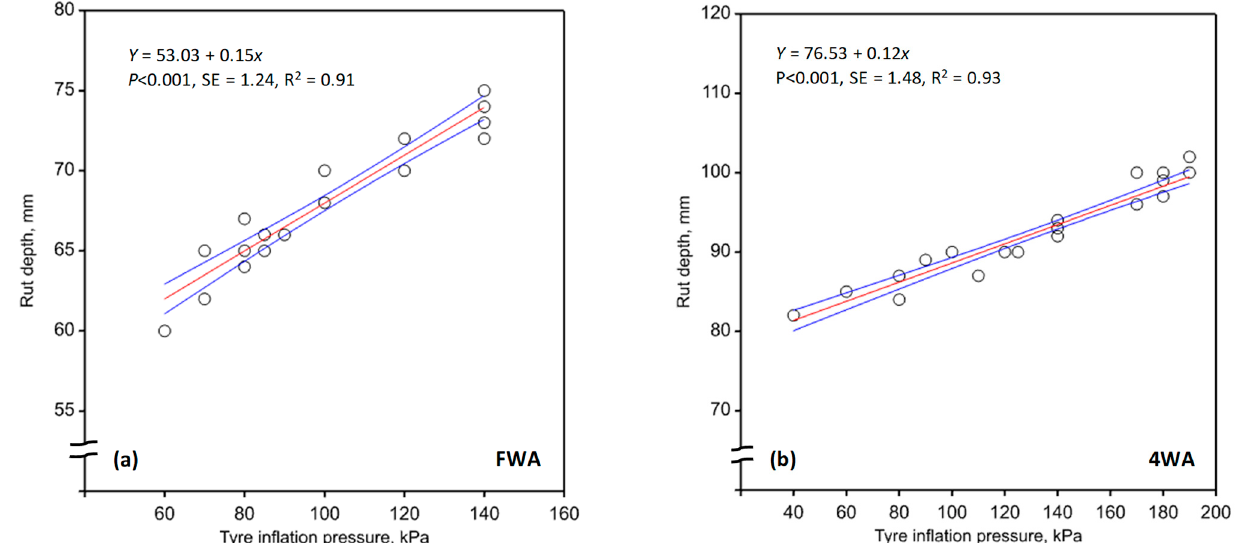
Figure 1. Observed relationships ( n = 30) between tyre inflation pressure and rut depth for ( a ) front- wheel assist (FWA) and ( b ) four-wheel drive (4WD) tractors used in this study (bulked data for all treatments). A description of treatments is shown in the caption of Table